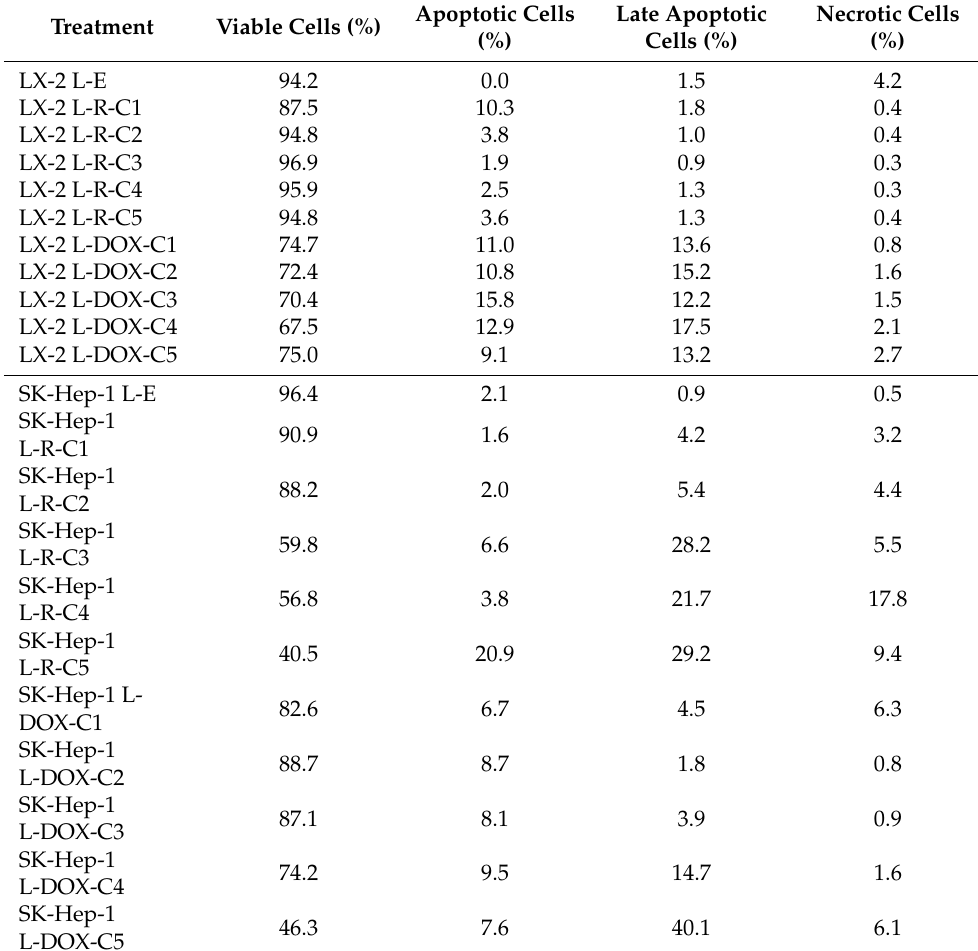
Table 3. Results of the apoptosis assays for the R. officinalis extract-loaded liposomes.